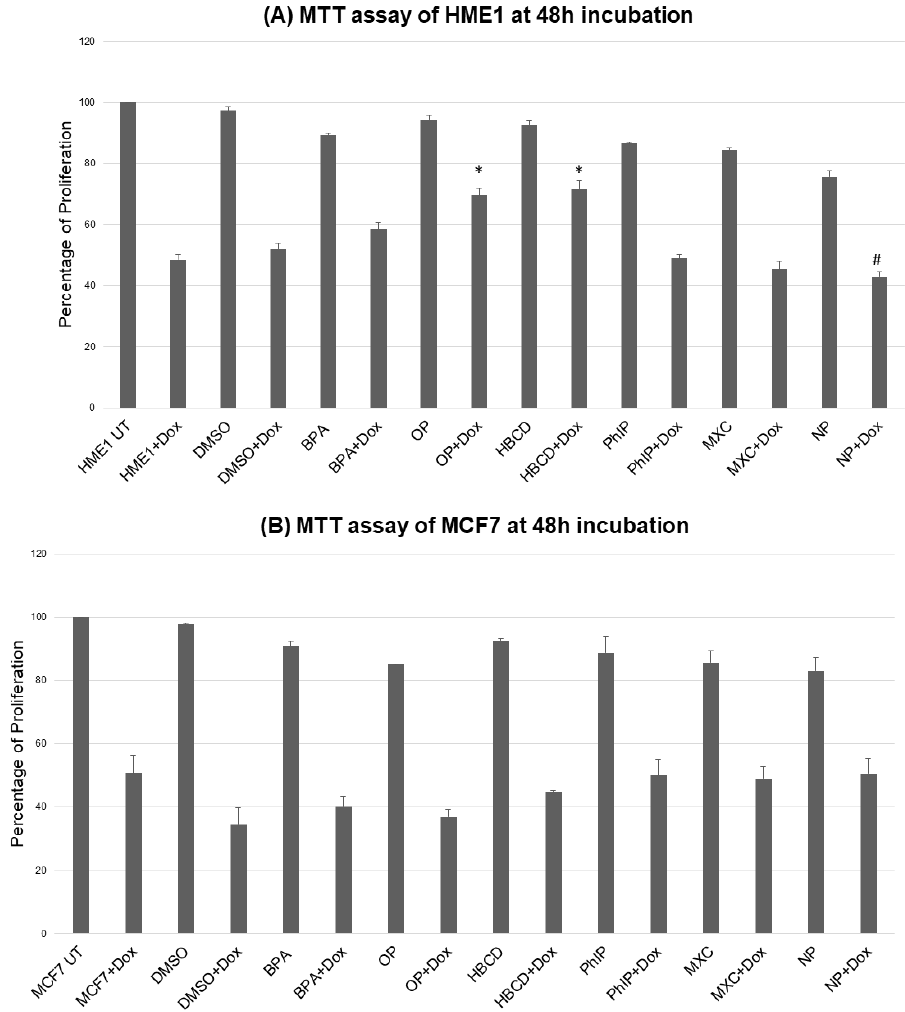
Figure 1. Representative graph showing altered viability of ( A ) HME1 and ( B ) MCF7 treated with nanomolar concentrations of various toxic agents (BPA, MXC, HBCD, NP, OP, PhIP at 0.0043, 0.0028, 0.0015, 0.0045, 0.0048, 0.0044 nM, respectively) alone or after overnight exposure to a therapeutic concentration of doxorubicin. Of note that, some toxic agents interfered with the killing e ff ect of doxorubicin. Mean ± SEM, * p < 0.05, # indicates a tendency ( p < 0.10), n = 3 (3 biological × 3